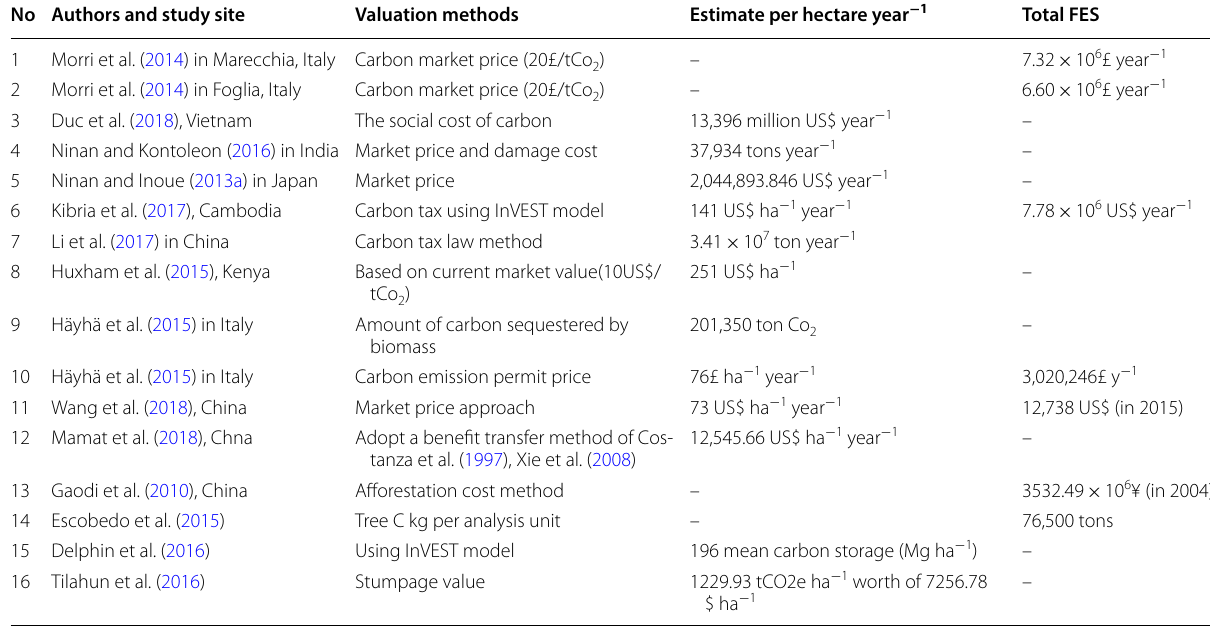
Table 5 Reviewed studies dealing with carbon sequestration including its methodology and monetary value